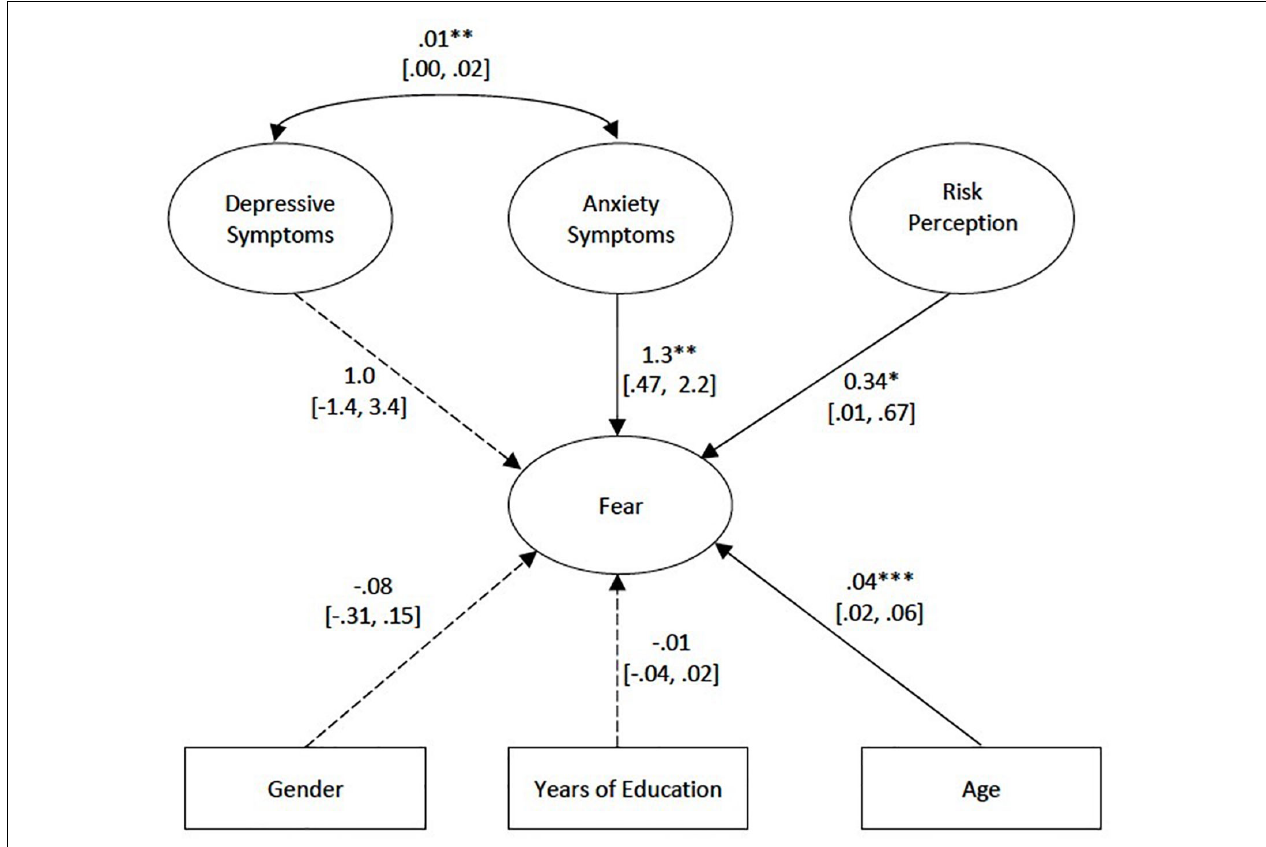
FIGURE 1 | Baseline model. Unstandardized regression estimates are shown. Solid lines are significant at p < 0.05, while dotted lines are non-significant. Ovals represent latent variables, while rectangles represent observed variables. Individual indicators in the questionnaires are omitted in the figures for simplicity. Figures in brackets represent the Confidence Intervals. * p < 0.05, ** p < 0.01, *** p <